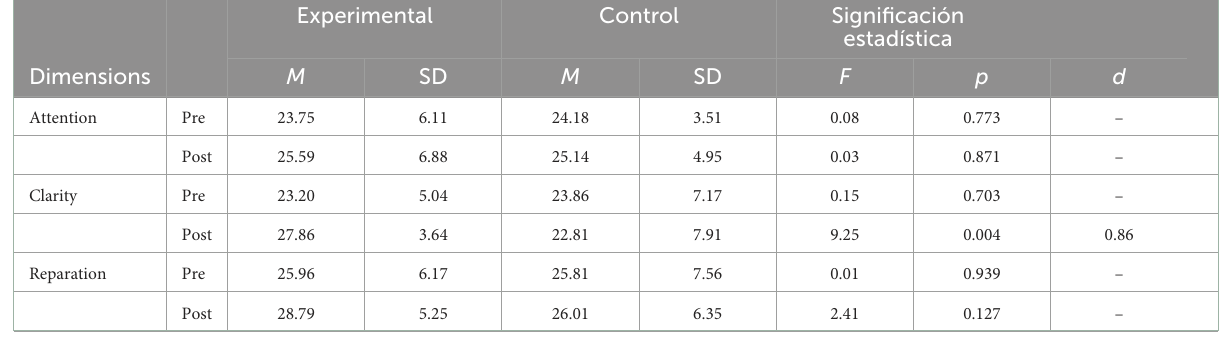
TABLE 4 Means and standard deviations in emotional intelligence variables of pre- and post-treatment groups: a posteriori contrasts. Experimental Control Significación Dimensions M SD Attention